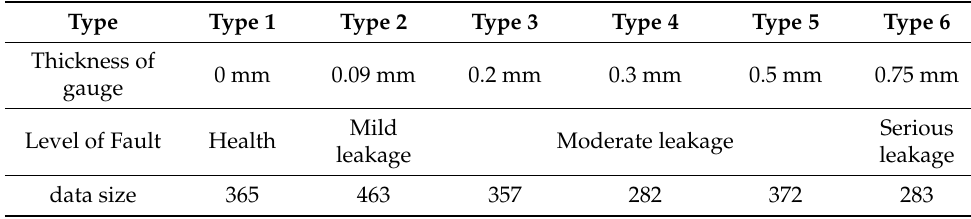
Table 1. The data size of various